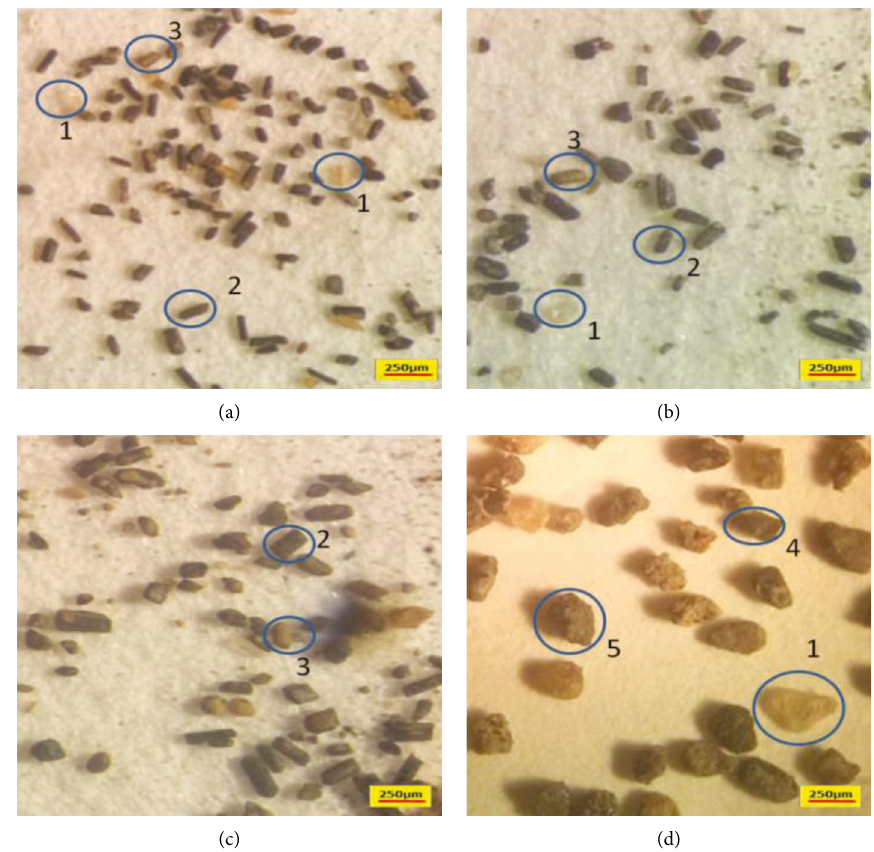
Figure 7: Images of the samples from the four sites ( A � SS; B � OTS; C � OLA; D � NCA) under binocular microscopes that show ash size and major mineral types (1 � quartz; 2 � augite; 3 � magnetite; 4 � hornblende; 5 � heavily altered